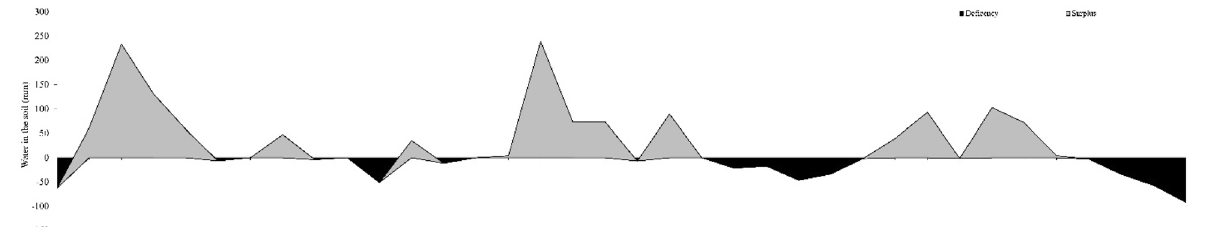
Figure 5. Monthly water deficit and surplus in the soil from September 2011 to July 2012, for a soil water holding capacity of 75